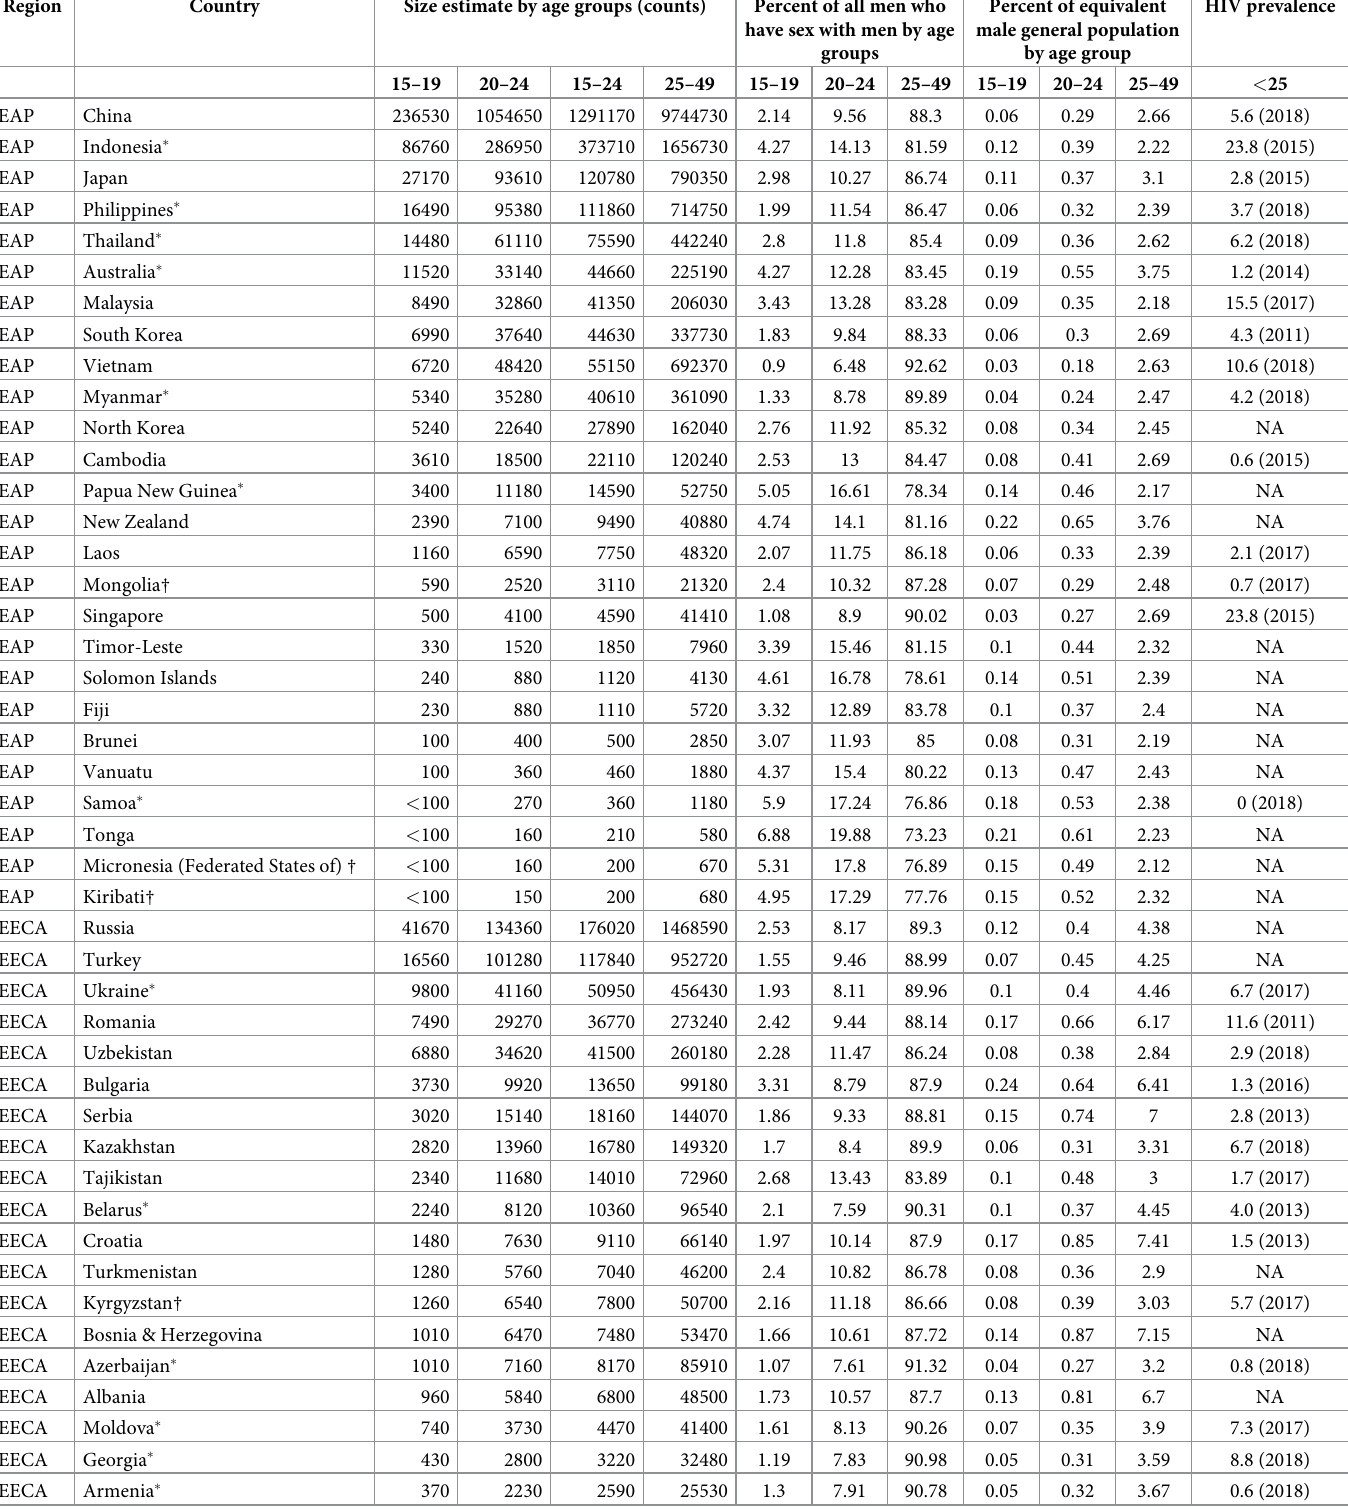
Table 2. Population size estimations for adolescent and young men who have sex with men, 2019.